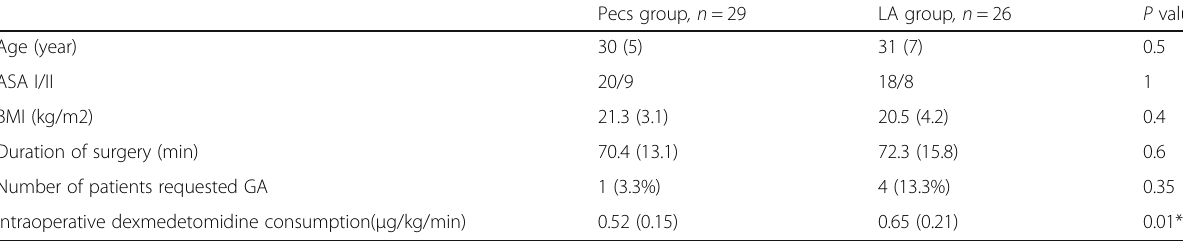
Table 1 Patient characteristics and operative